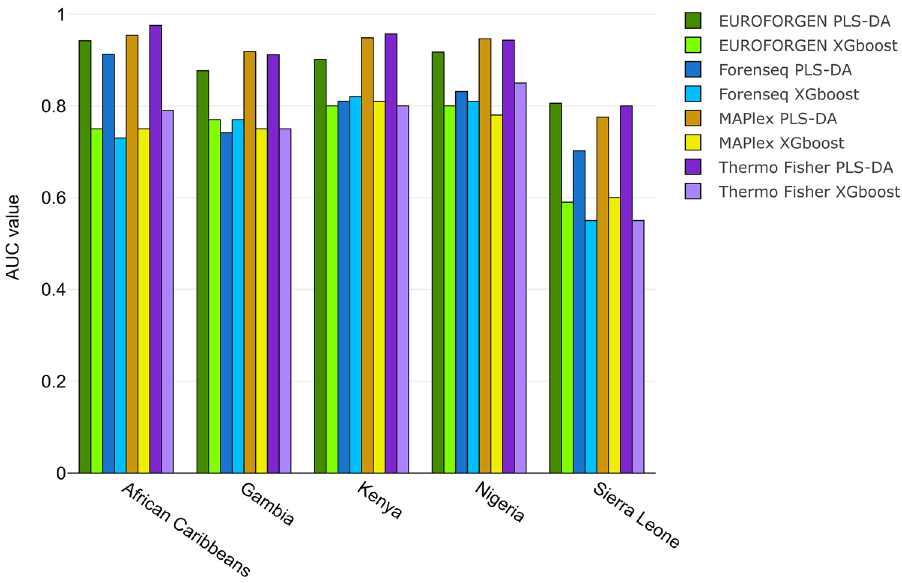
Figure 8. Comparison of AUC values obtained fromPLS-DA and XGBoost model for African